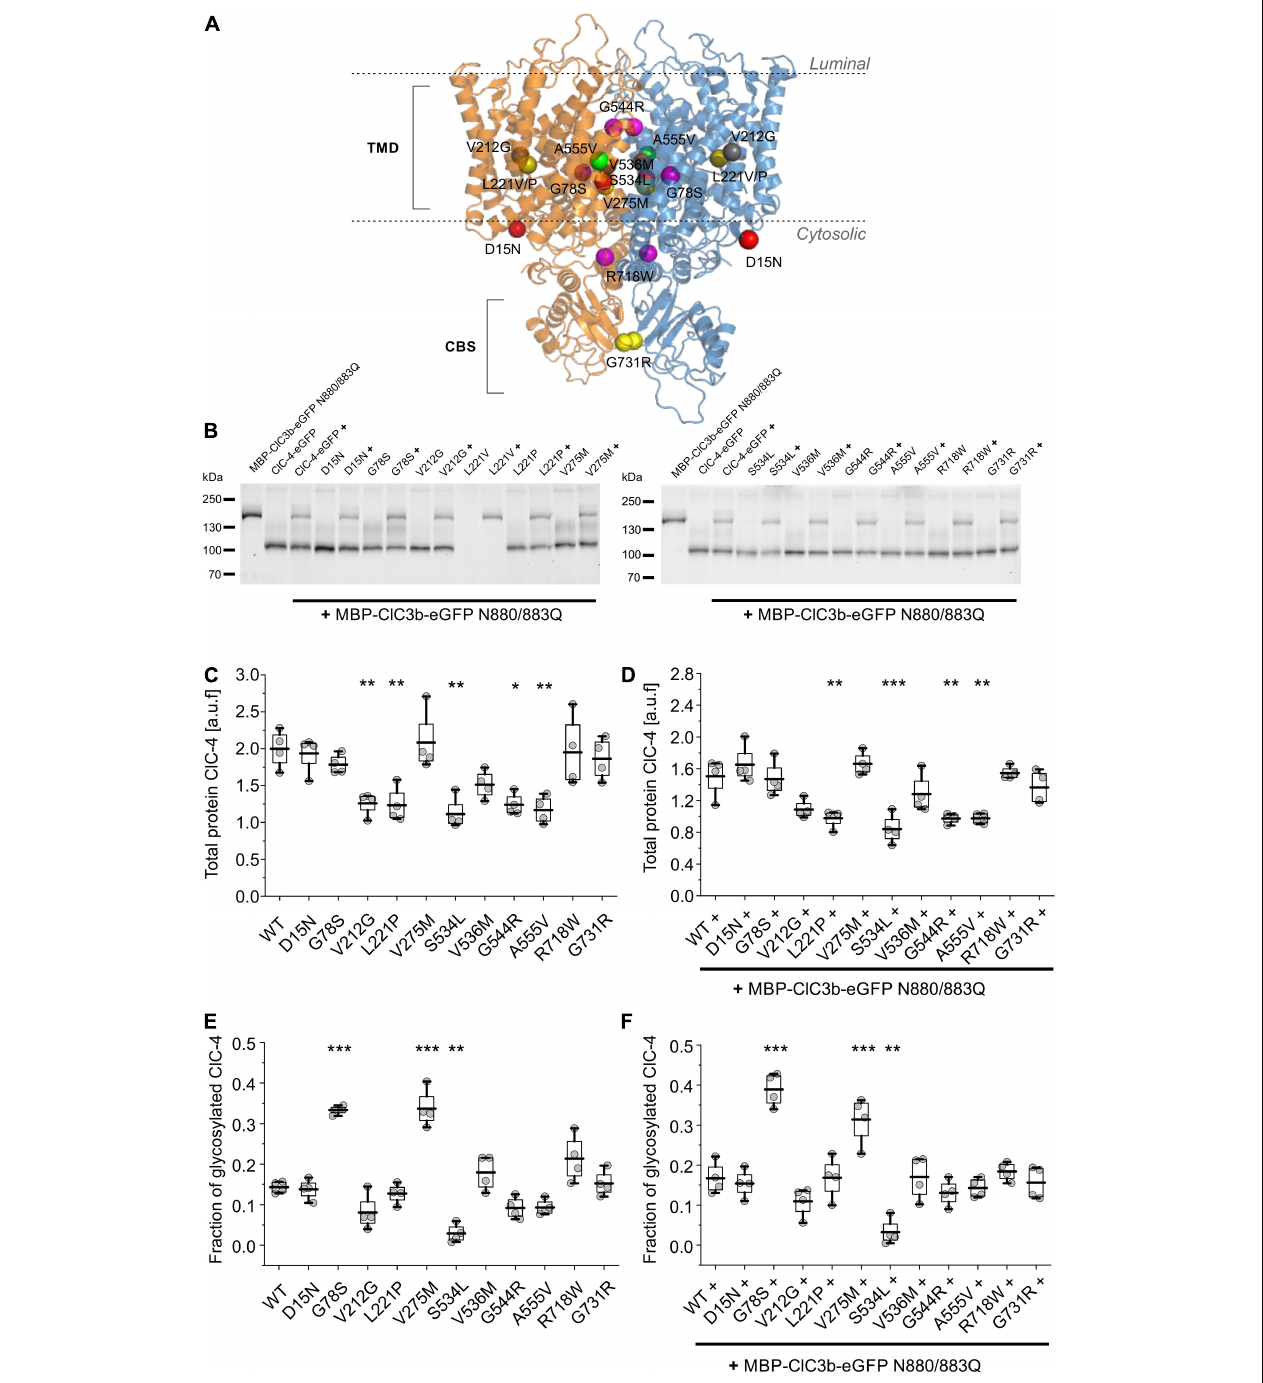
FIGURE 1 | Effects of disease-causing mutations on protein expression and stability. (A) Position of amino acid substitutions examined in this study mapped onto the backbone fold of an atomic-resolution model of the human ClC-4 dimer generated using AlphaFold-Multimer (Evans et al., 2021). (B) Representative SDS-PAGE analysis of lysates from HEK293T cells expressing WT or mutant ClC-4, alone or with ClC-3b. (C,D) Total WT or mutant ClC-4-eGFP protein amounts were estimated by quantifying fluorescence intensities in SDS-PAGE of lysates from HEK293T cells expressing ClC-4 (C) alone or (D) with ClC-3b (a.u. denotes arbitrary units). (E,F) Ratio of the intensities of complex glycosylated to total WT or mutant ClC-4-eGFP fluorescence from HEK293T cells expressing ClC-4 (E) alone or (F) with ClC-3b. ClC-4 variants were compared with WT using one-way analysis of variance (with Tukey’s HSD post hoc testing), *** p < 0.001, **p < 0.01, and *p < 0.05. Data were obtained from four independent experiments and are represented as boxplot boxes indicating upper and lower quartiles and whiskers indicating upper and lower 90%.